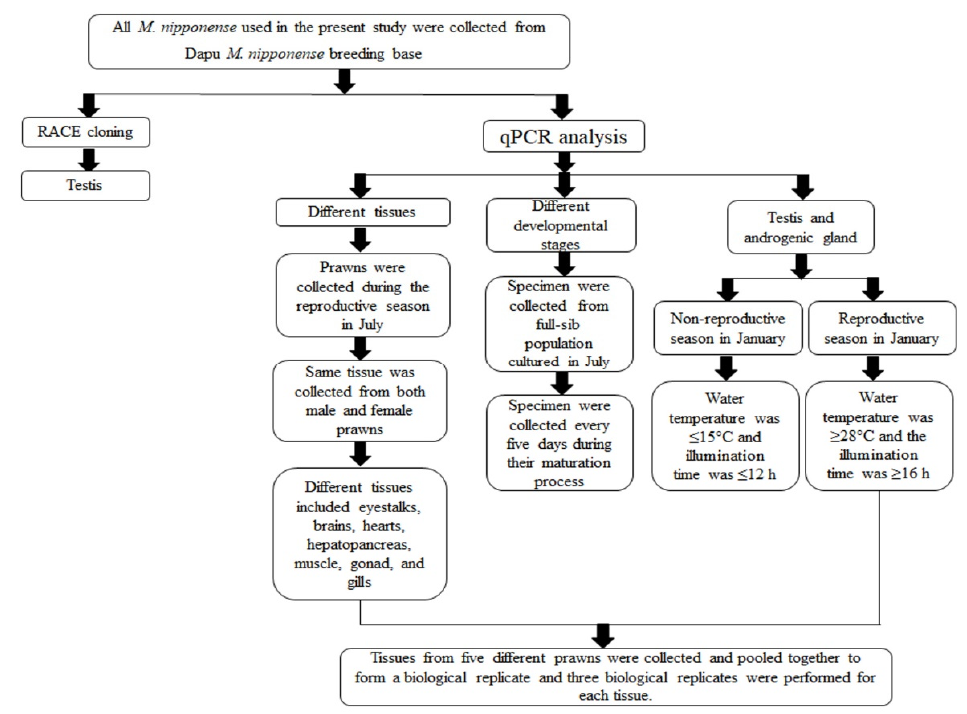
Figure 1. Flowchart showing the sample collection procedure.